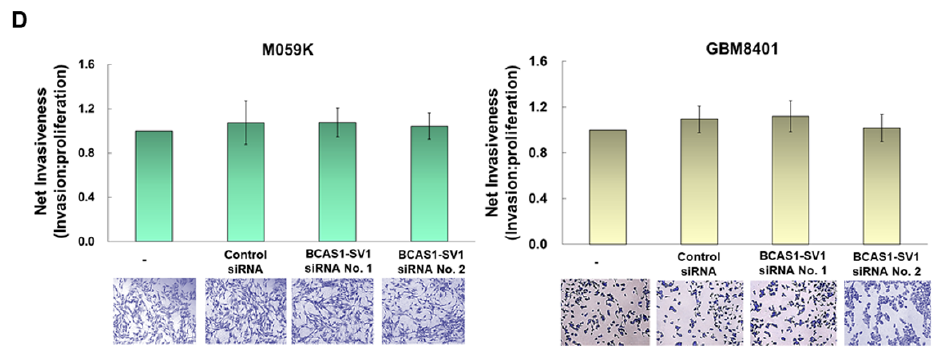
Figure 3. BCAS1-SV1 siRNA significantly decreased the proliferation and migration but not invasion of GBM cells. M059K (left) and GBM8401 (right) cells were transfected with BCAS1-SV1 RNA interference (RNAi) for 24 h. ( A ) BCAS1 and BCAS1-SV1 expressions were analyzed by RT-PCR (top) and Western blotting (bottom). Primers were designed on exon 7 and exon 11 to obtain 479-bp (BCAS1) and 202-bp (BCAS1-SV1) products. Anti-BCAS1 and anti-myc antibodies were used to detect BCAS1 and BCAS1-SV1. β -actin was an internal control. ( B ) Proliferation of BCAS1-SV1 siRNA- treated M059K (left) and GBM8401 (right) cells was determined by CellTiter Blue Cell Viability assay. ( C ) Migration of BCAS1-SV1 siRNA-treated M059K (left) and GBM8401 (right) cells was determined by scratch wound assay. Bars, width of the initial scratch gap at the start of the experiment. A migratory index, Im, was defined as Im = (g0 − g12)/g0, where g12 and g0 are the gap widths at time 12 and time 0, respectively. ( D ) Invasion of BCAS1-SV1 siRNA-treated M059K (left) and GBM8401 (right) cells was determined by InnoCyte Cell Invasion Assay. Following incubation for 24 h, the fluorescence in cells that had invaded the basement membrane was quantified (top) or stained with crystal violet (bottom).